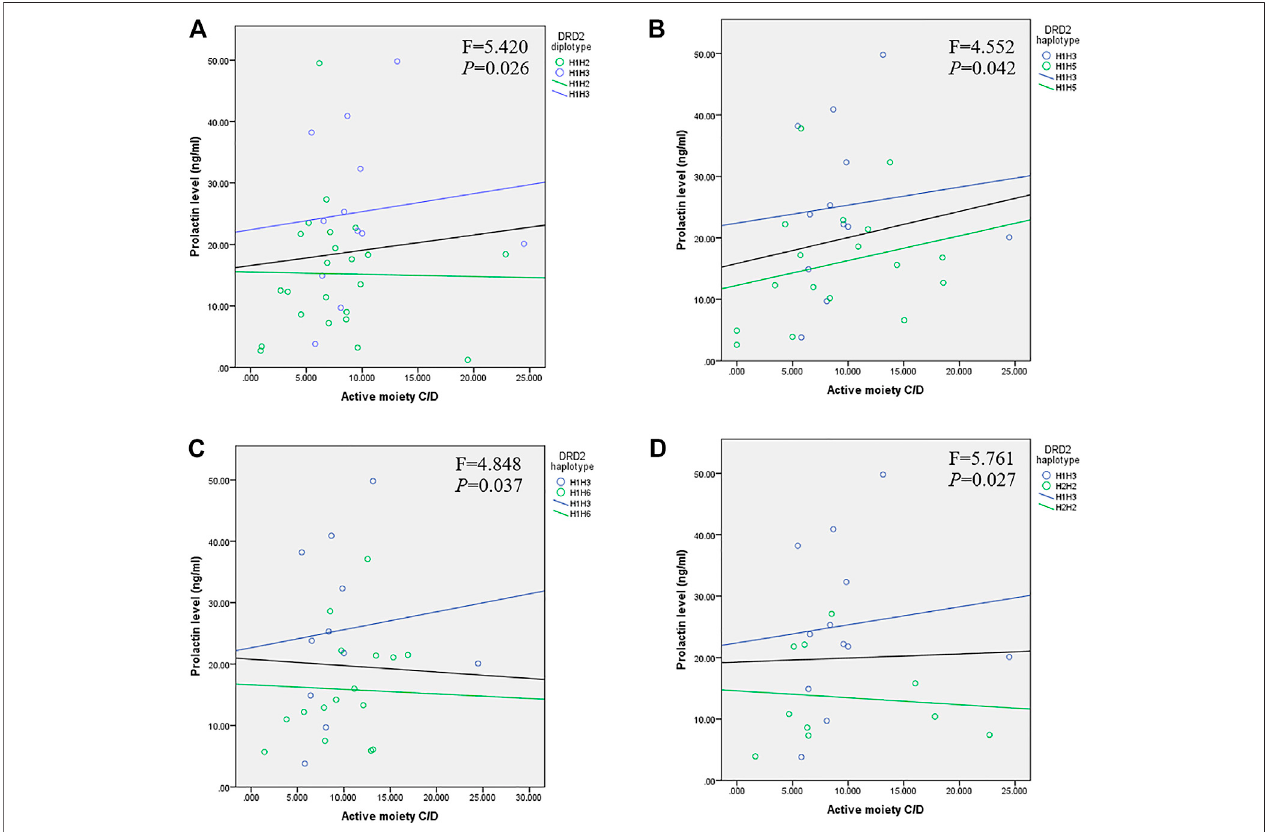
FIGURE 1 | Relationship between prolactin and active moiety C/D plasma levels in children and adolescents with DRD2 diplotypes of (A) H1/H3 and H1/H2 ( p (cid:1) 0.026), (B) H1/H3 and H1/H5 ( p (cid:1) 0.042), (C) H1/H3 and H1/H6 ( p (cid:1) 0.037), and (D) H1/H3 and H2/H2 ( p (cid:1) 0.027). The black line represents the linear relationship between prolactin and drug levels in patients carrying an H1/H3 or other diplotype.